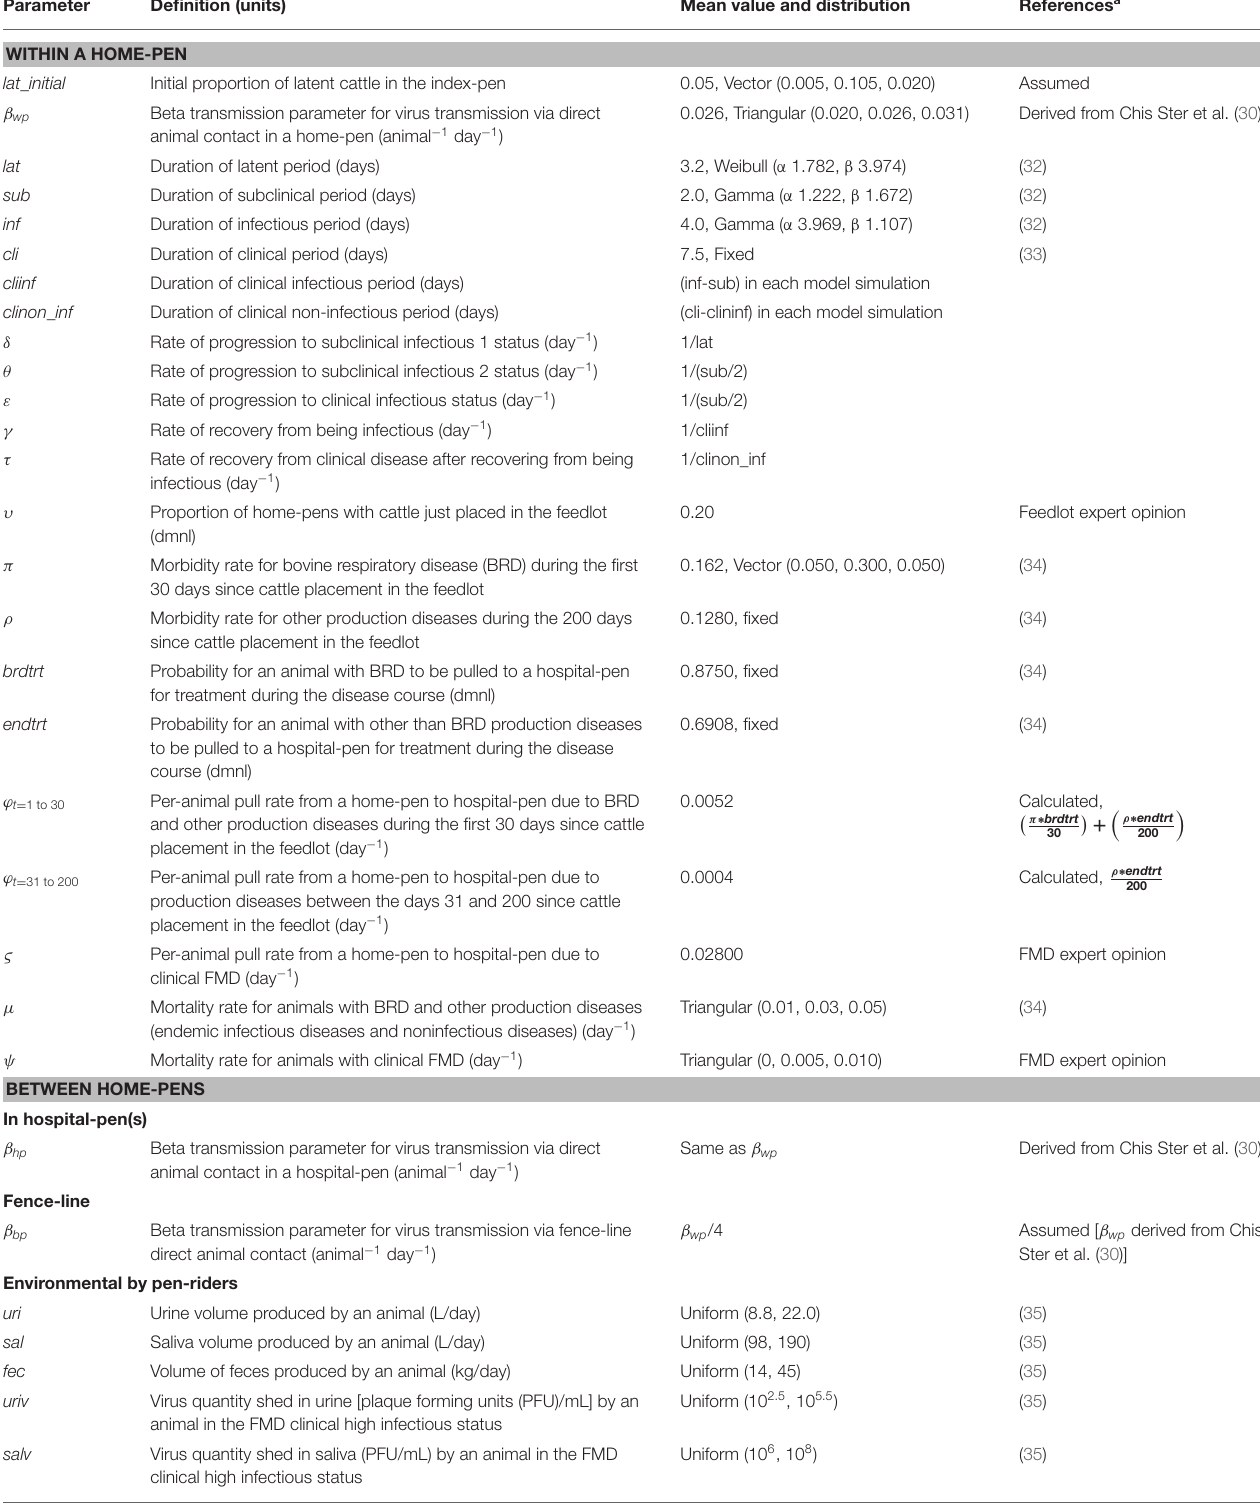
TABLE 1 | Definitions and values of parameters used in modeling potential foot-and-mouth disease transmission, infection, and clinical manifestation dynamics on U.S. beef cattle feedlots.